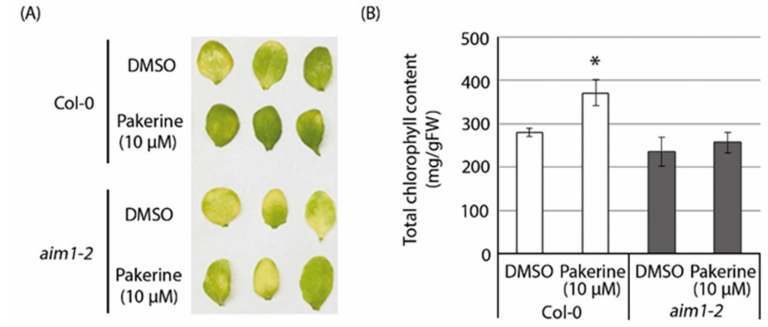
Figure 8. Pakerine does not alleviate dark-induced senescence in the absence of AIM1. ( A ) Representative images of detached aim1-2 and wild-type Arabidopsis leaves incubated on liquid MS medium supplemented with pakerine (10 µ M) or DMSO (control) for seven days in darkness. ( B ) Total chlorophyll content of leaves treated as in ( A ). Data points represent means of 12 individual leaves ± SE. Asterisks indicate significant di ff erences according to one-way ANOVA with LSD post hoc test ( p <